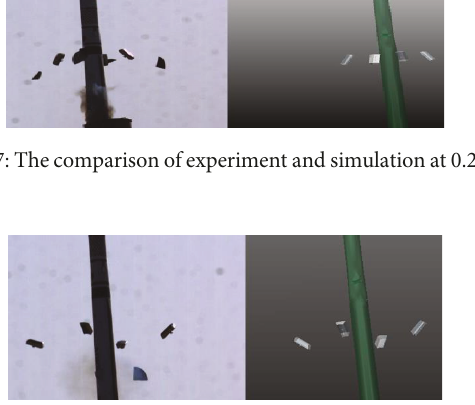
Figure 8: The comparison of experiment and simulation at 0.3403s.